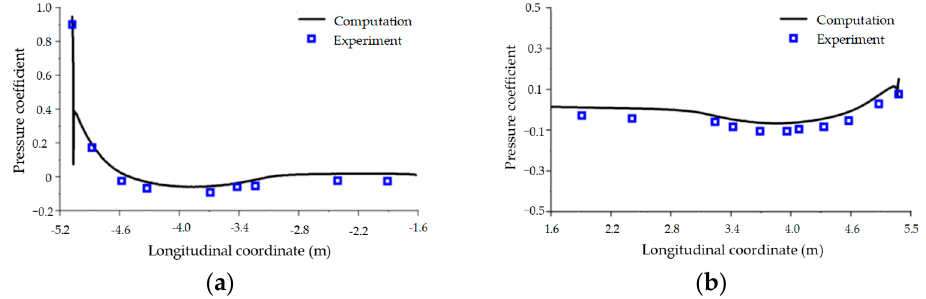
Figure 5. Comparison of the pressure coefficient: ( a ) Head car, ( b ) tail car.